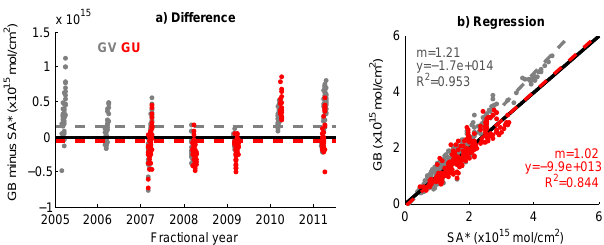
Fig. 14. (a) Absolute difference (circles) and mean absolute dif- ference (dashed line) between GBS-vis (grey) and GBS-UV (red) minus SAOZ NO 2 partial column measurements. The solid black line indicates zero. (b) Correlation for GBS-vis (grey) and GBS-UV (red) versus SAOZ NO 2 partial column measurements. The solid black line indicates the 1-1 line and the dashed line indicates linear fit ( m =fitted slope, y =fitted